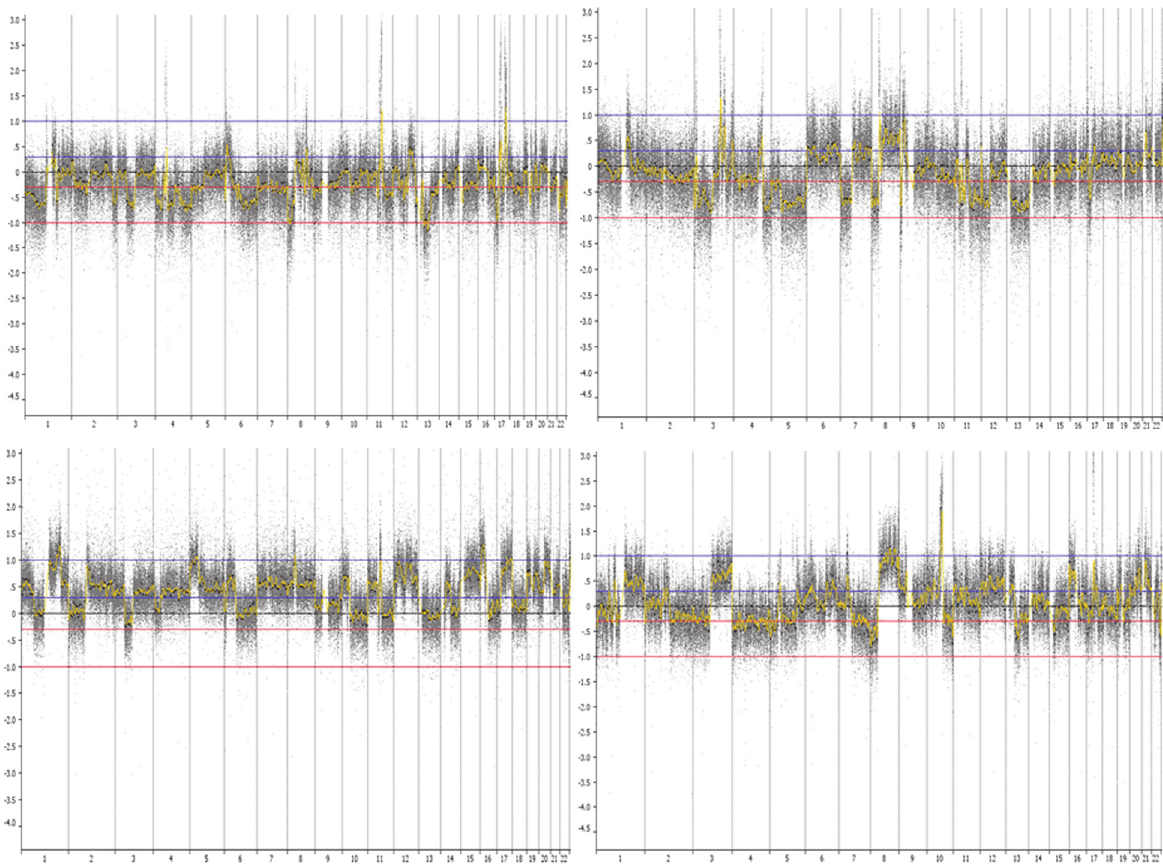
Fig 1. Array-CGH images of CCSS cases displaying “ complex-amplifier ” genomic profiles. Test and reference DNA were labeled with different dyes and co-hybridized to Agilent CGH arrays containing 180,000 probes tiled across the genome. The chromosome number is shown at the bottom of the figure. Y axis shows the log2 ratios. Low-level copy number gains and losses were defined as absolute log2 ratios larger than 0.3. Amplifications were defined as log2 ratios larger than 1.